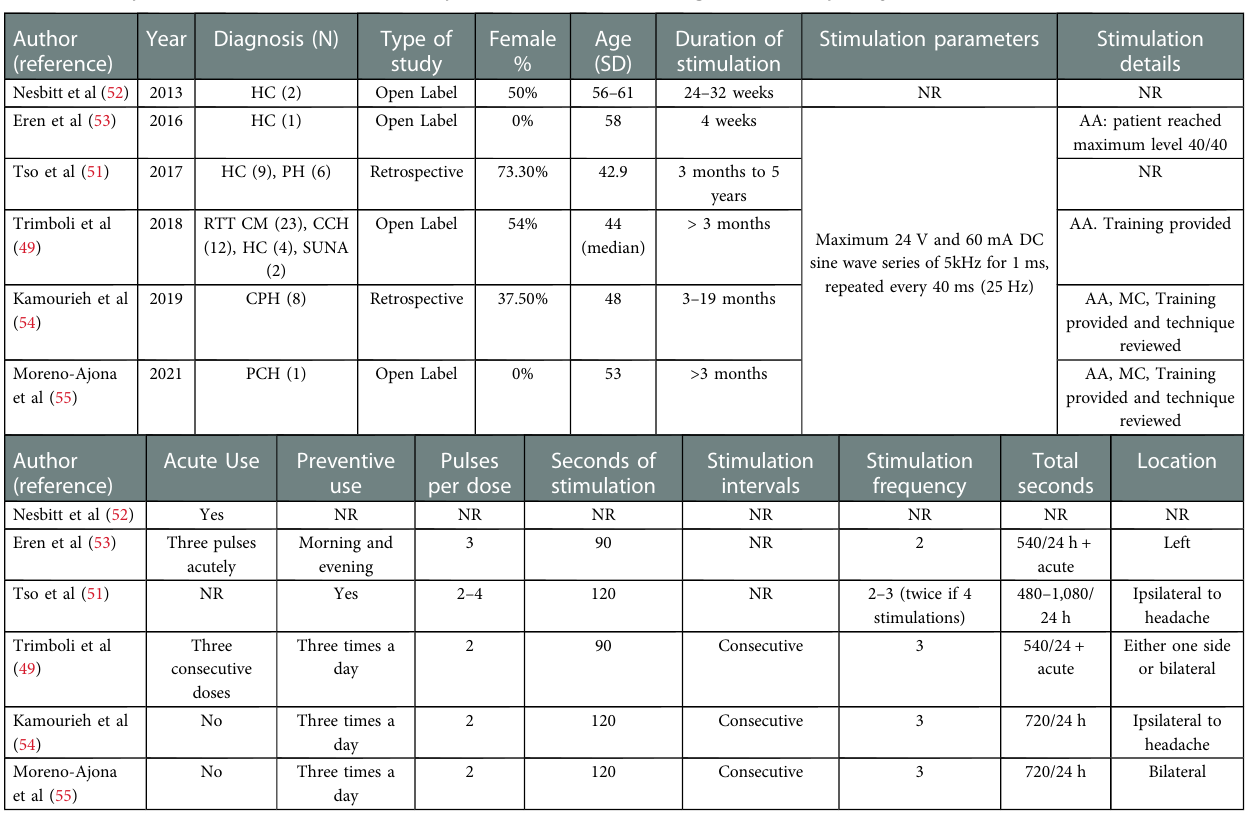
TABLE 2 Participant ’ s characteristics and stimulation parameters of studies assessing nVNS in rarer primary